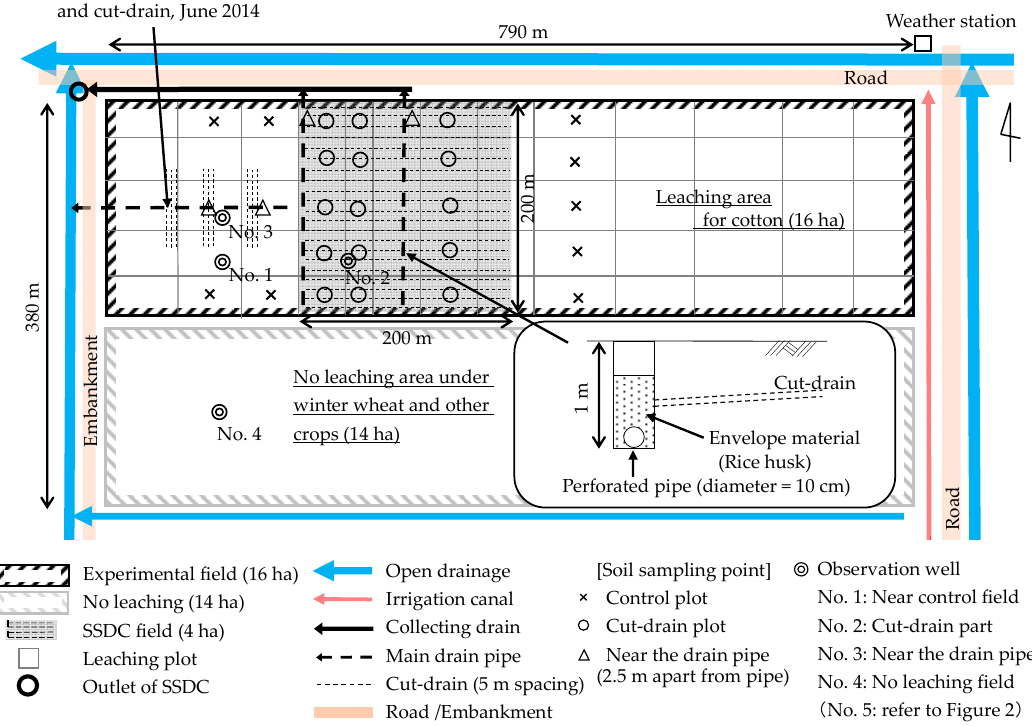
Figure 4. Layout of the experimental field on the farm. The figure shows the location and cross-sectional drawing of the shallow subsurface drainage used in combination with “cut-drains” (SSDC) field. The sampling points are shown in the plot of the control field, cut-drain part and near the drain pipe. The locations of four observation wells are shown by each